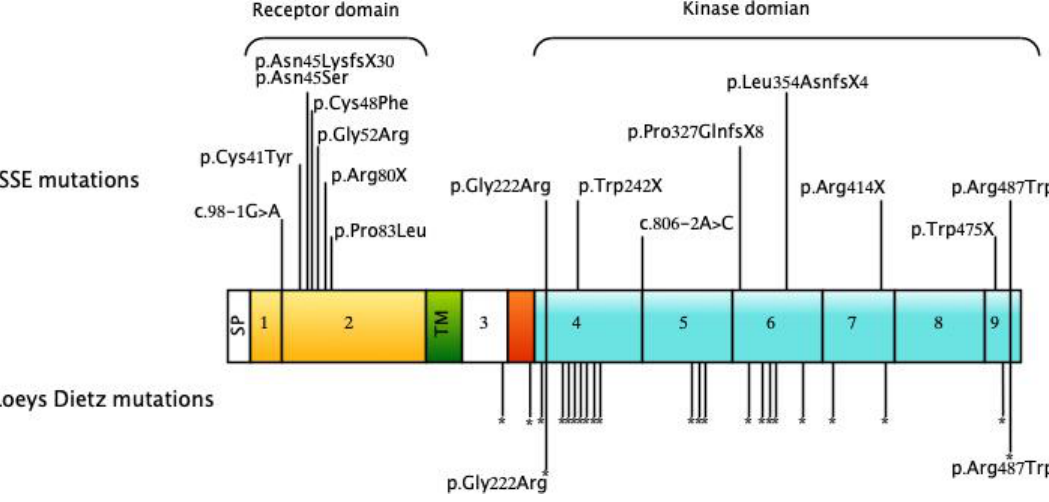
Figure 4. Mutations in TGFBR1 in individuals with MSSE (modified from Reference [9] Domain structure of the TGF β RI protein showing reported MSSE mutations [6,9,12–16] and unpublished data). The MSSE mutations are shown above the protein while the locations of missense mutations reported in Loeys Dietz syndrome [17–29] are indicated by asterisks below. The location of the c.1459C > T, p.(Arg487Trp) and c.664G > A, p.(Gly222Arg) variants found in patients with both MSSE and Loeys Dietz phenotypes are also shown. Functional domains are color-coded: extracellular ligand-binding domain (yellow), transmembrane domain (green), glycine-serine-rich domain (red), cytoplasmic kinase domain (blue). SP, signal peptide; TM, transmembrane